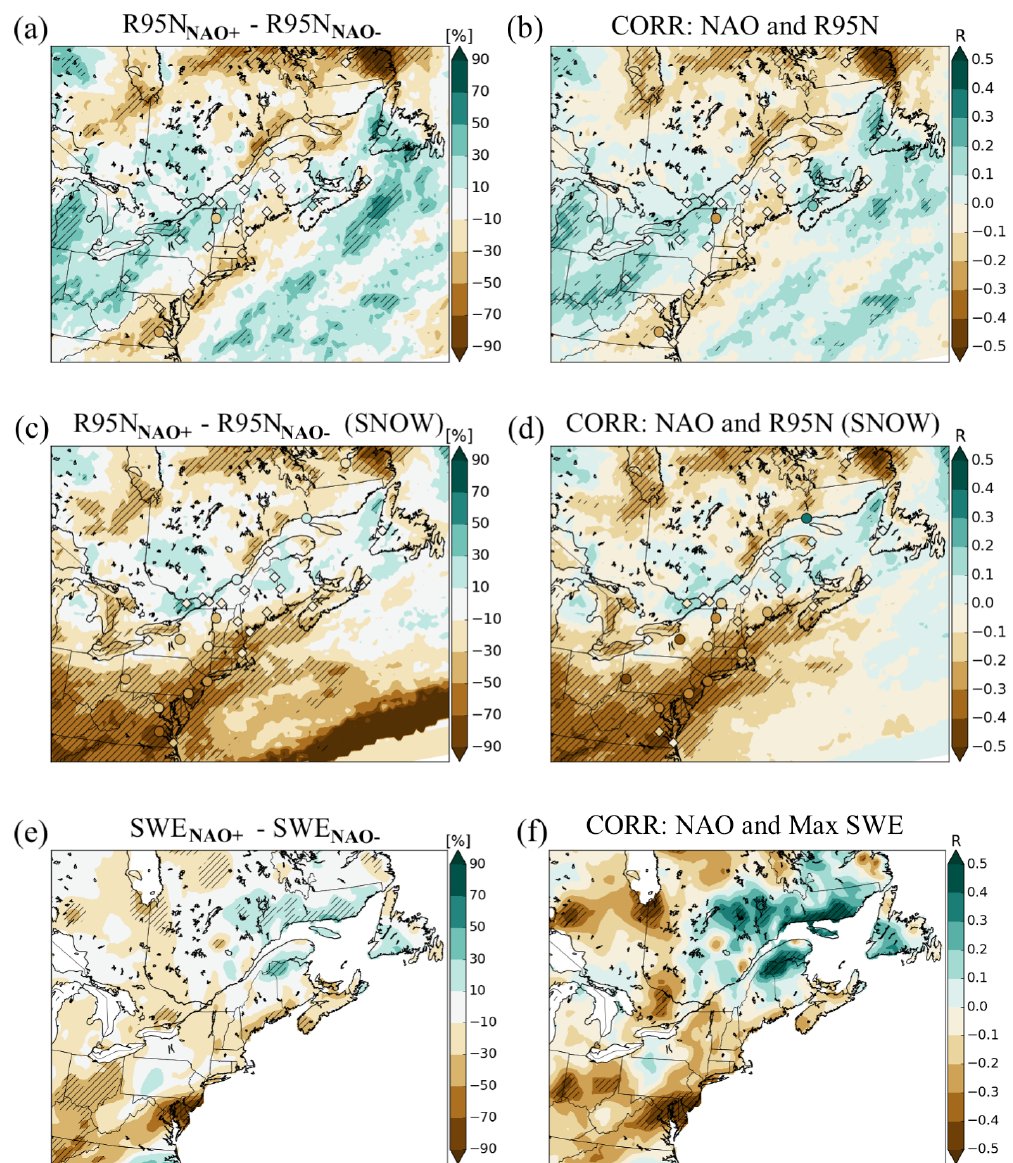
Figure 5. (a) Relative difference between the number of heavy precipitation days (above 95th percentile of daily precipitation, R95N) during positive NAO and negative NAO months (40-month composites, first and fourth quartiles) in winter (DJFM). (b) Correlation coefficients between number of heavy precipitation days and monthly NAOI. Hatched areas represent statistically significant values at the 0.05 level. Shaded circles represent station-based correlation coefficients that are statistically significant at the 0.05 level, and diamonds represent values that are not statistically significant. (c, d) As in panels (a) and (b) but for the relationship between monthly NAO and the number of heavy snowfall days (above 95th percentile of daily snowfall). (e, f) As in panels (a) and (b) but for the relationship between cold season averaged NAO and annual maximum snowpack